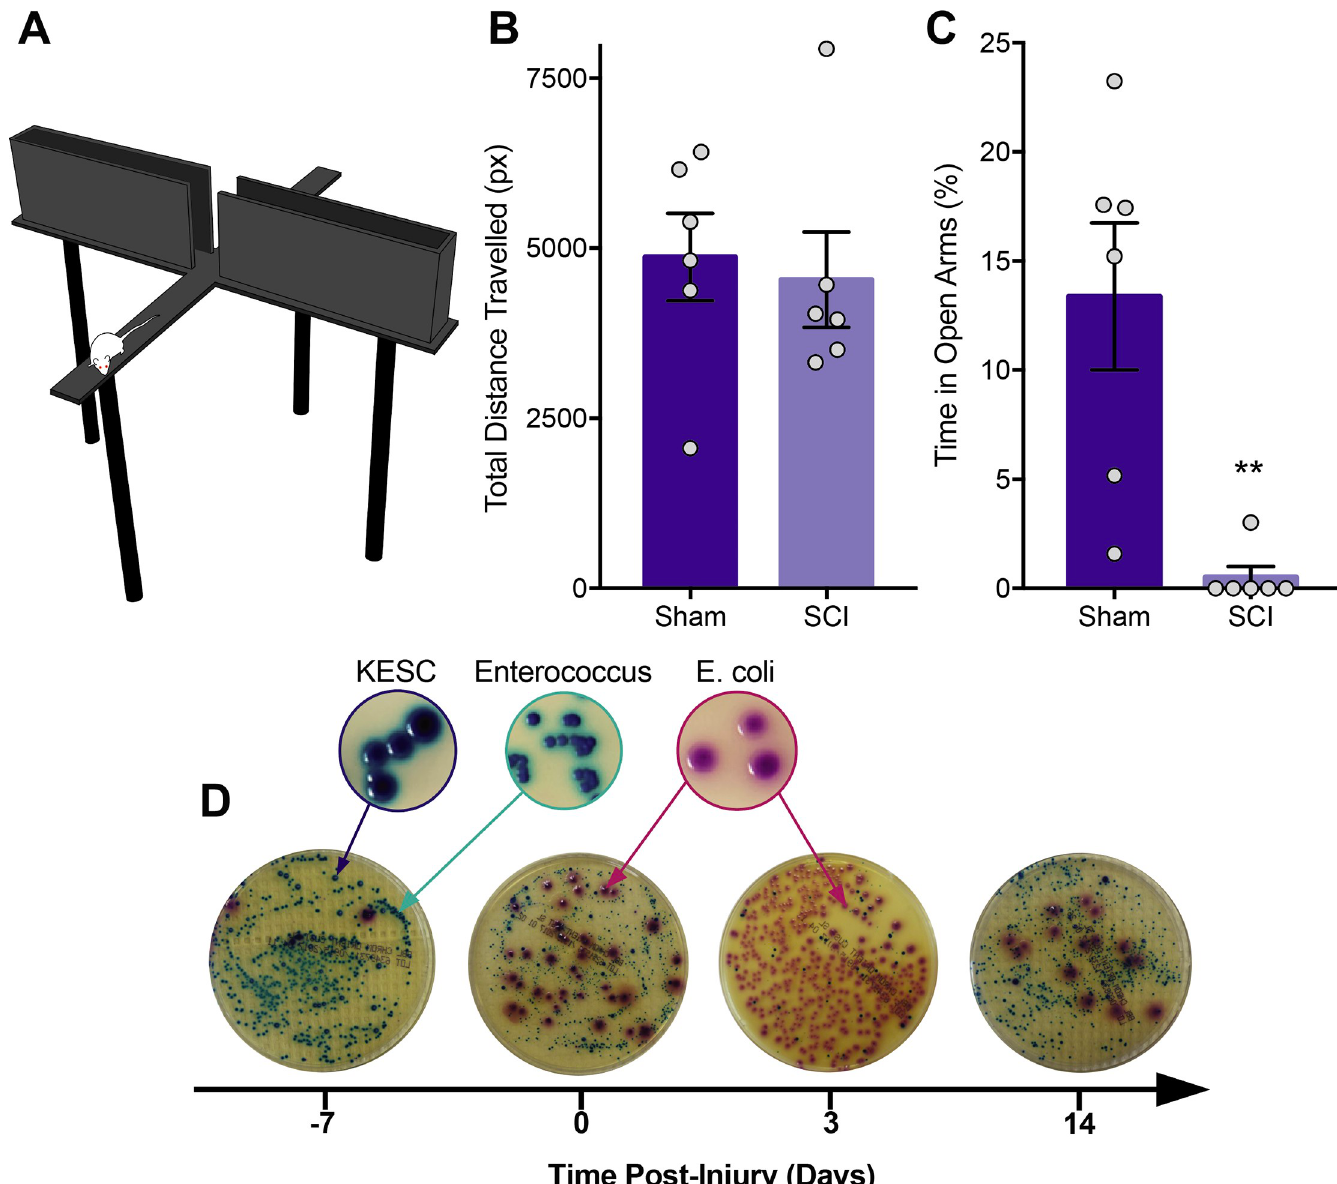
Fig 1. Cervical spinal cord injury in rats induces anxiety-like behaviour and alterations in gut microbiota. The elevated plus maze, shown in (A) , was tested 3 weeks following spinal cord injury (SCI). (B) There was no difference in the total distance travelled between SCI and sham operated groups. Sham = 4869 px ± 1579, SCI = 4536 px ± 1713. (C) After SCI, rats spent significantly less time in the open arms compared to sham animals (Mann-Whitney test, p = 0.0043; Sham = 13.37% ± 8.26, SCI = 0.50% ± 1.23) (D) Fecal matter from SCI rats were collected at various time points, filtered and diluted with PBS using sterile techniques, and plated onto CHROMagar orientation plates to assess bacterial growth over 48 hours. Immediately following injury (time 0) there was clear alterations in microbial growth, with maximal changes seen 3 days after injury. �� p < 0.01.